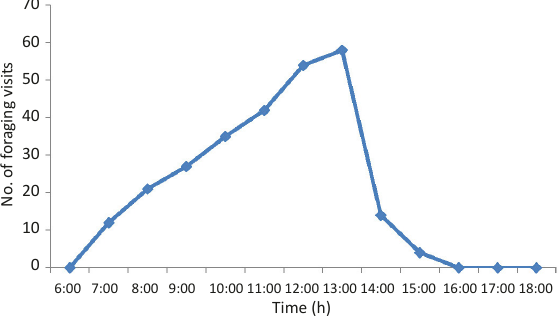
Figure 2. Hourly foraging activity of Rhynchium wasp on Eriolaena hookeriana (average of foraging visits recorded on three different days Tirumala and Ananthagiri sites in 2011 and 2012